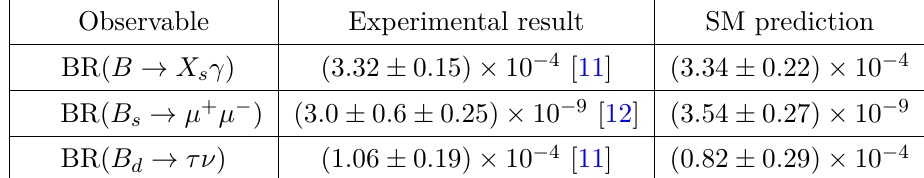
Table 2 . Experimental results and SM predictions for selected flavour